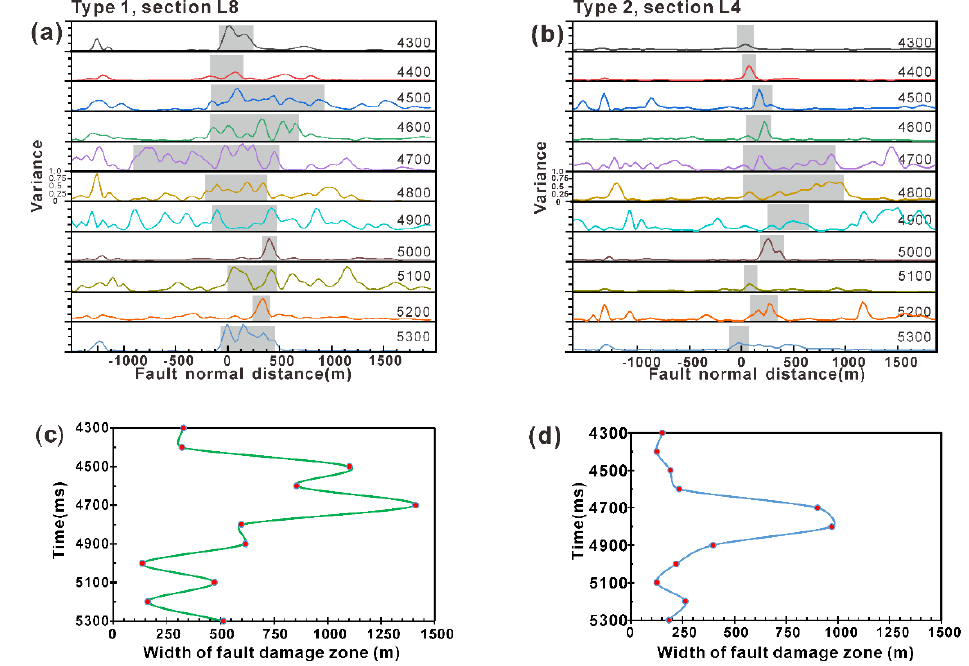
Figure 8. Variance damage zone variations with depth intervals from 4300 ms to 5300 ms. The data in ( c , d ) are derived from the damage zones (light grey areas) interpreted in ( a ) (section L8) and ( b ) (section L4), respectively.